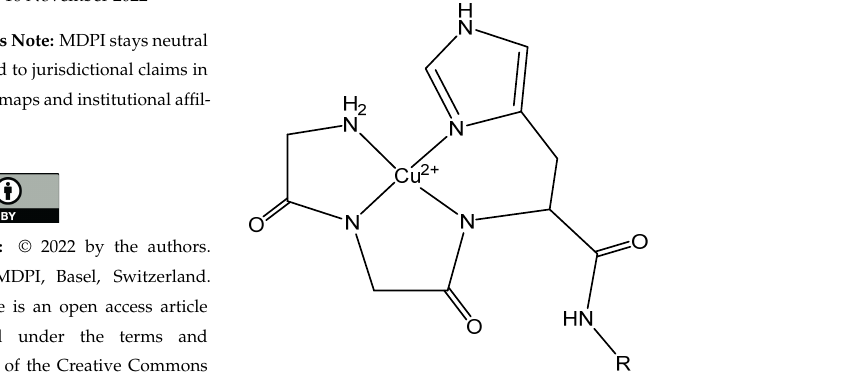
Figure 1. Structural detail of the ATCUN motif at the N-terminus of an AMP (R).